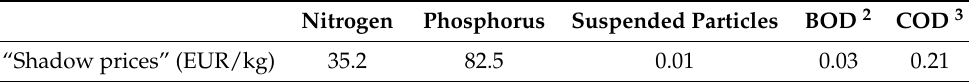
Table 9. “Shadow prices” of relevant pollutants in water 1